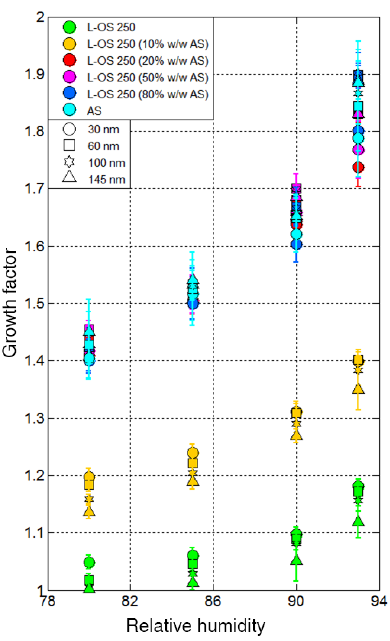
Figure 4. Hygroscopic growth factor (HGF) as a function of rel- ative humidity (RH) for particles of pure L-OS 250, pure AS and mixtures hereof. Growth factor is given for four dry particle diam- eters of each chemical composition. Each data point represents the mean HGF obtained from four to six measurements, and the error bars express ± 2 standard deviations as described in Sect.